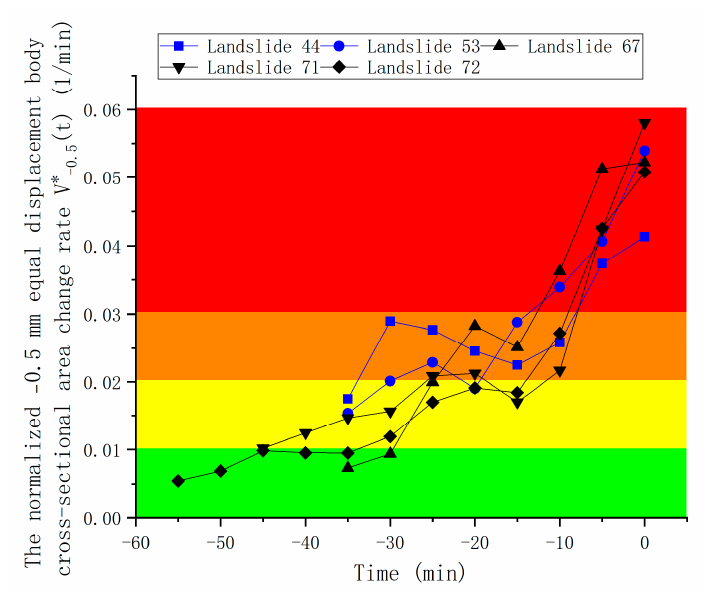
Figure 13. The normalized − 0.5 mm equal displacement body cross-sectional area change rate.